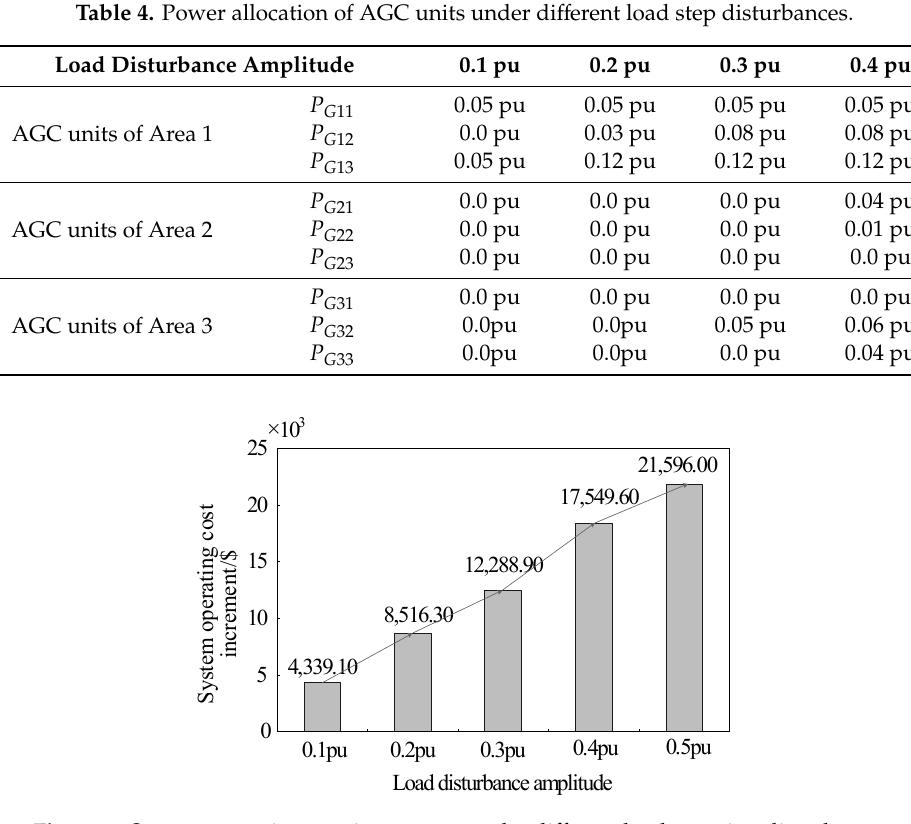
Figure 6. System operating cost increments under different load stepping disturbances.